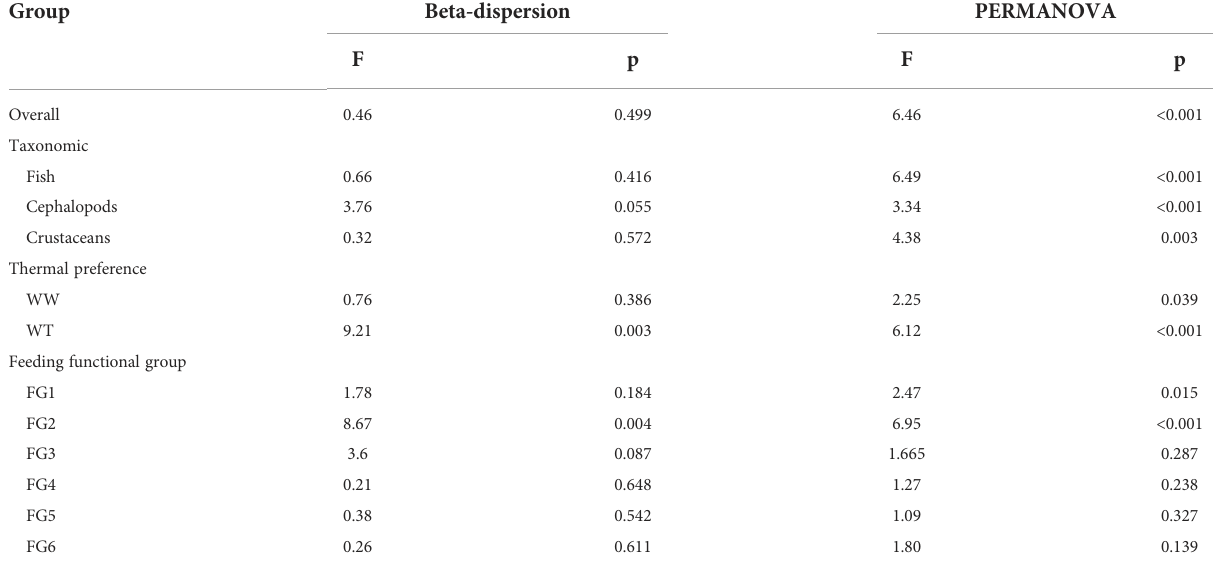
TABLE 2 Results of two-way ANOVA for dispersion and centroid differences in the community dissimilarity of different groups between sampling years and locations.